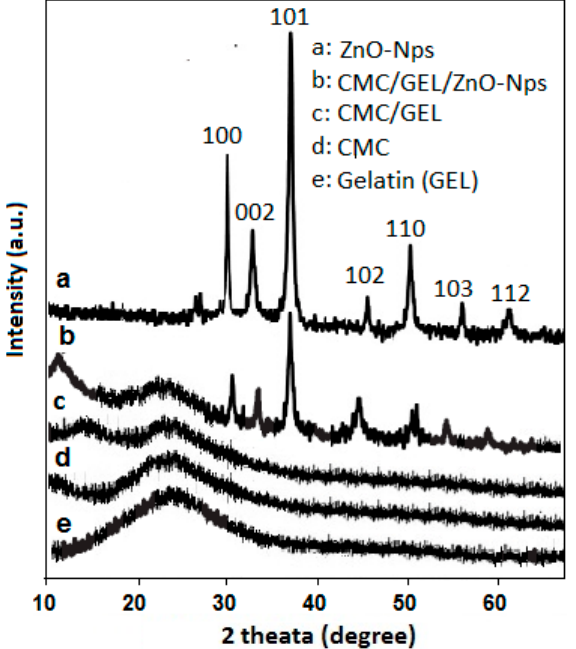
Figure 2. XRD pattern of CMC/Gel/ZnO nanocomposites hydrogels.